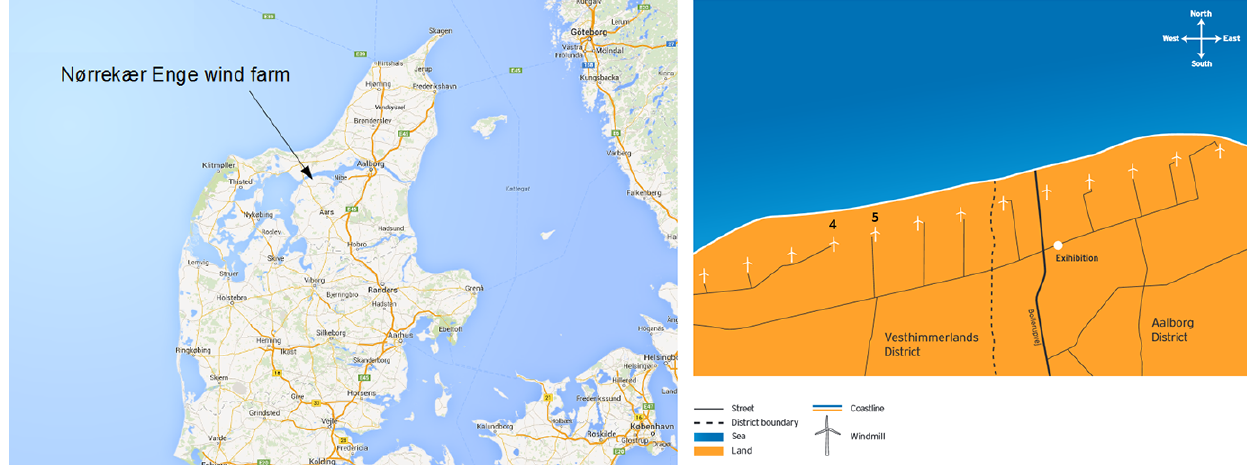
Figure 1. Left: location of the wind farm in Denmark. Right: location of the 13 wind turbines in the wind farm. The wind turbines are numbered 1 to 13 from left to right.